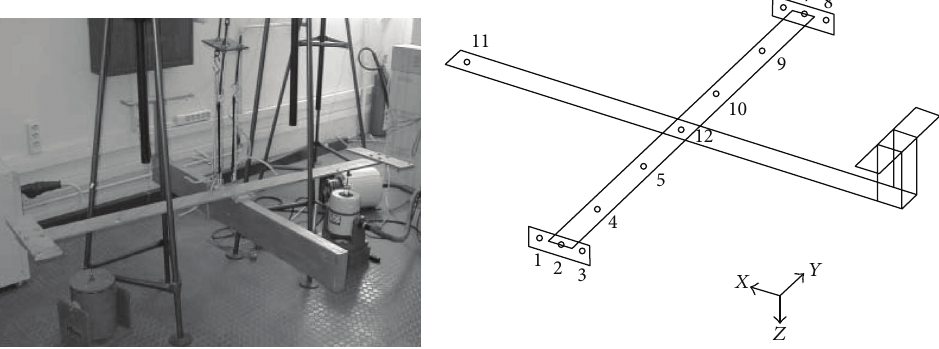
Figure 9: Aircraft skeleton structure [9].